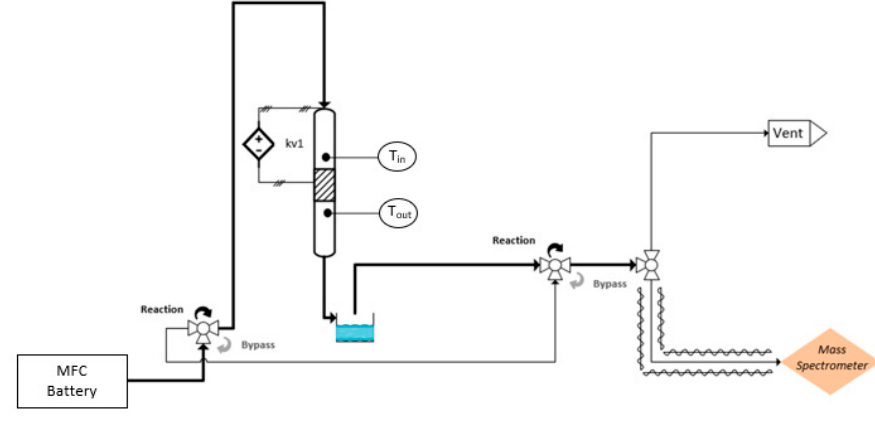
Figure 14. Experimental plant design.